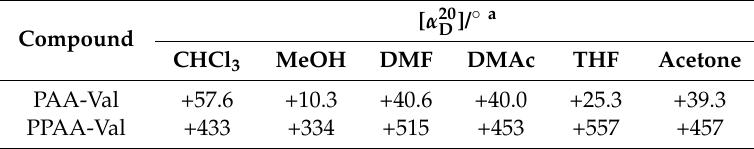
Table 1. Specific optical rotations of PAA-Val and PPAA-Val in different solvents. Compound